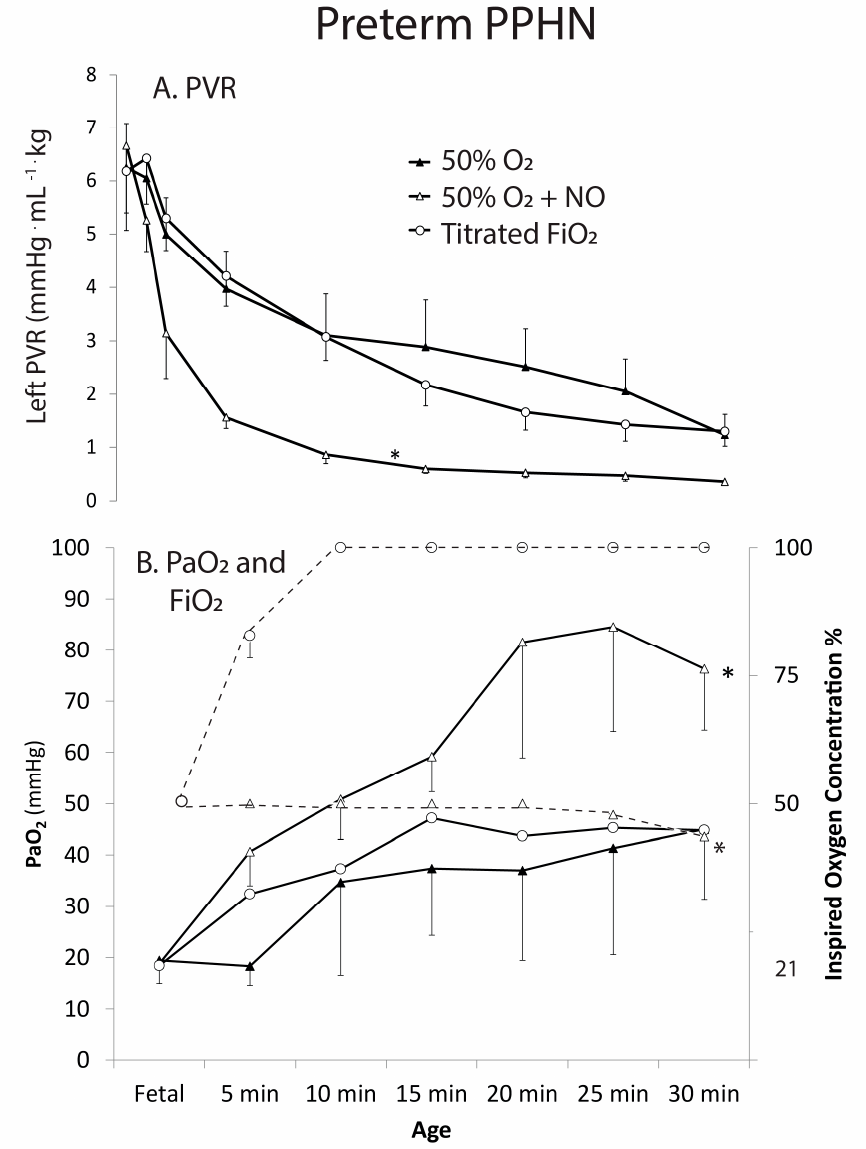
Figure 4. Changes in total pulmonary vascular resistance (PVR) in both lungs ( A ) and PaO 2 ( B ) in PPHN lambs exposed to 50% oxygen (solid triangles) vs initiation with 50% oxygen and iNO and titration (open triangles) and titrated oxygen (open circles). Inspired oxygen concentration in the titrated oxygen group (open circles) and titrated oxygen with iNO (open triangles) is represented by a hyphenated line (* p < 0.05 compared to corresponding value without